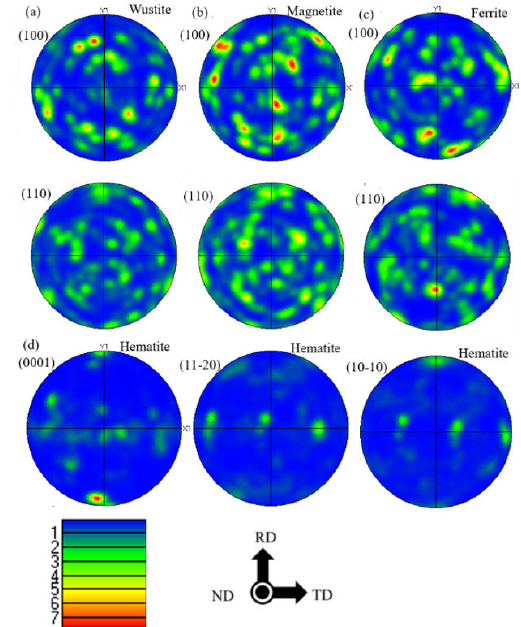
Figure 9. Polar diagrams of the oxide layer and steel matrix on different crystal planes for ( a ) FeO, ( b ) Fe 3 O 4 , ( c ) ferrite, and ( d ) (0001), (10 − 10) and (11 − 20) PF for Fe 2 O 3 , with a TR of 10%, and a CR of 11 ◦ C/s.